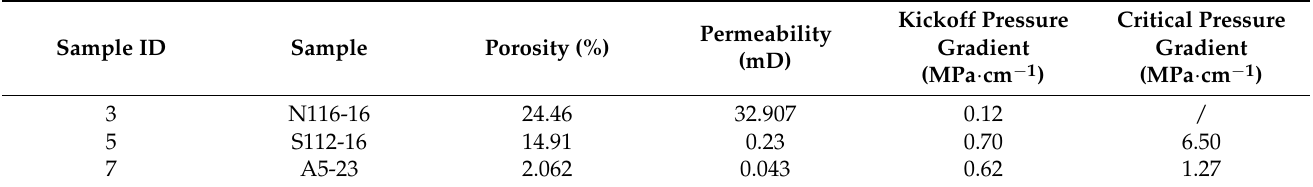
Table 7. Fitting equations and key migration pressure gradients of oil flow in migration.